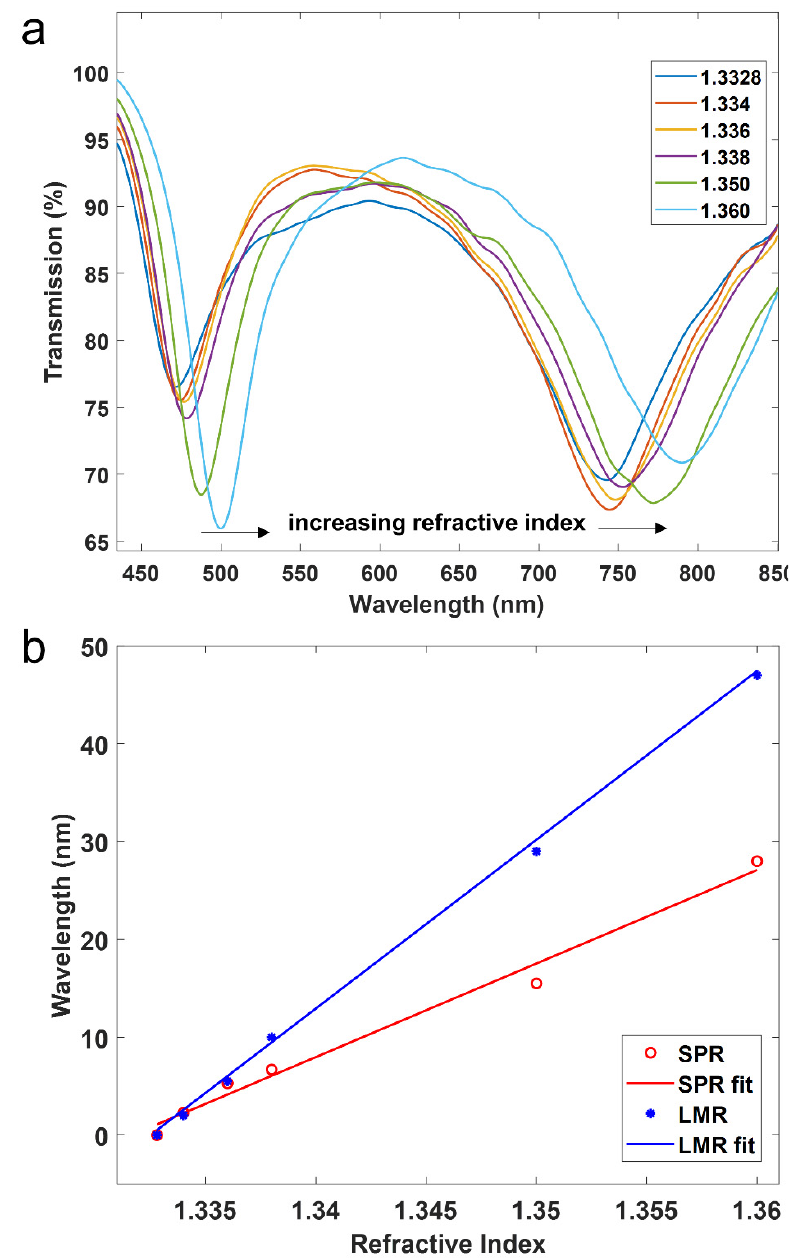
Figure 6. ( a ) Transmission spectra (TM polarization) for different surrounding medium refractive indices. ( b ) Relative wavelength shift as a function of refractive index for both the LMR and SPR.